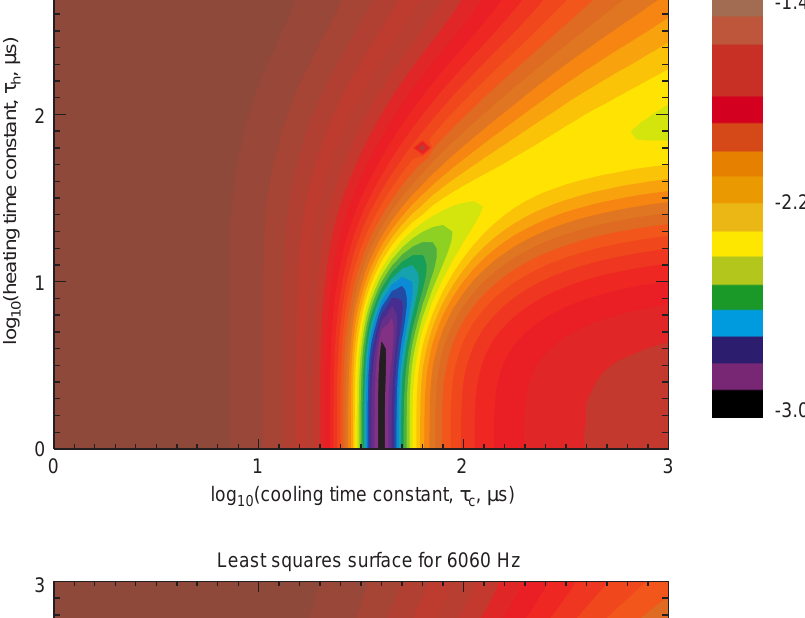
Fig. 13. Contours of log (least squares 10 error) in fitting the experimental magnetic field strength data, measured as a function of duty cycle, to the estimates of the field strength derived theoretically from the ion- ospheric heating and cooling time constants. Evaluations for EVEN harmonics. Upper panel : 6th harmonic, 3030 Hz. Lower panel 12th harmonic,